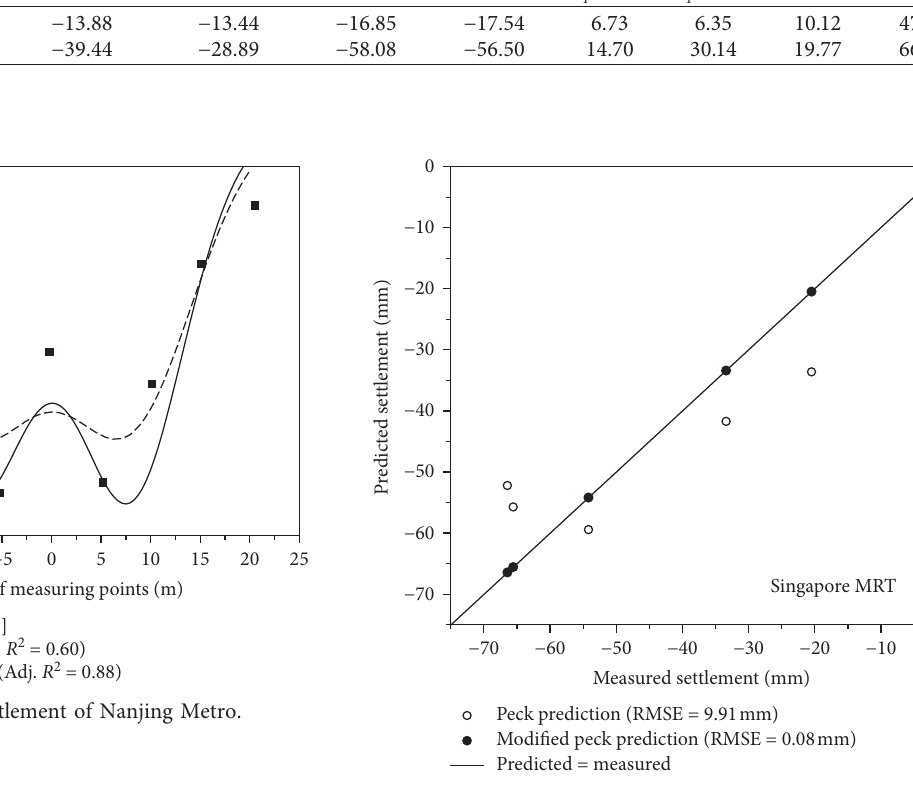
Figure 16: Comparison of predicted settlement for Singapore